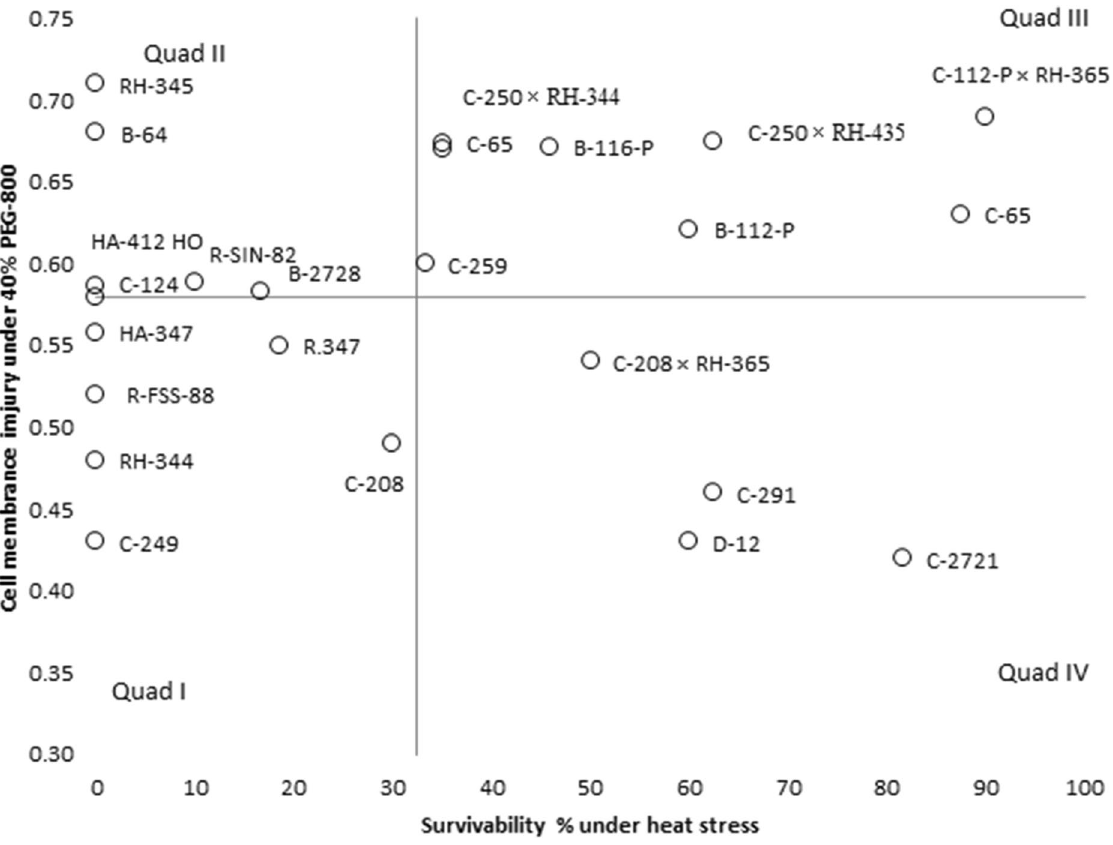
Figure 5. Relationship of survivability % under heat stress with 40% PEG induced cell membrane injury.